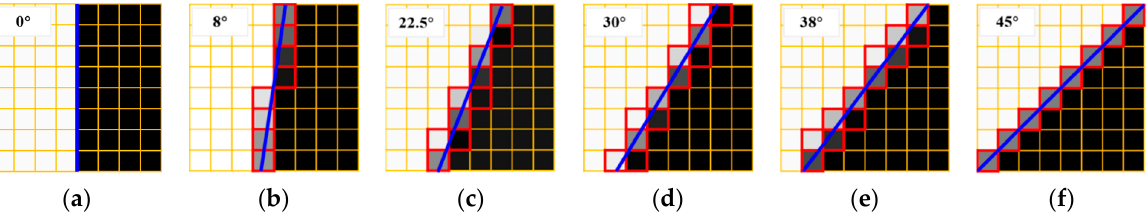
Figure 7. Diagrams of degradation due to sampling for different tilt angle edges: ( a ) when edge angle is 0 deg, ( b ) when edge angle is 8 deg, ( c ) when edge angle is 22.5 deg, ( d ) when edge angle is 30 deg, ( e ) when edge angle is 38 deg, ( f ) when edge angle is 45 deg.